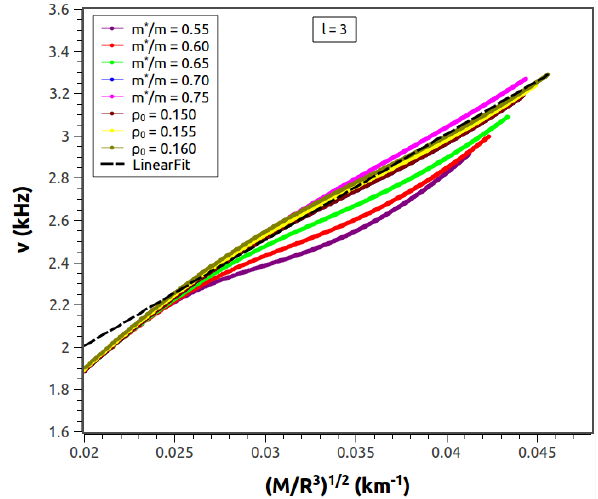
Figure 10. Same as Figure 9 but for higher-order l = 3 mode.